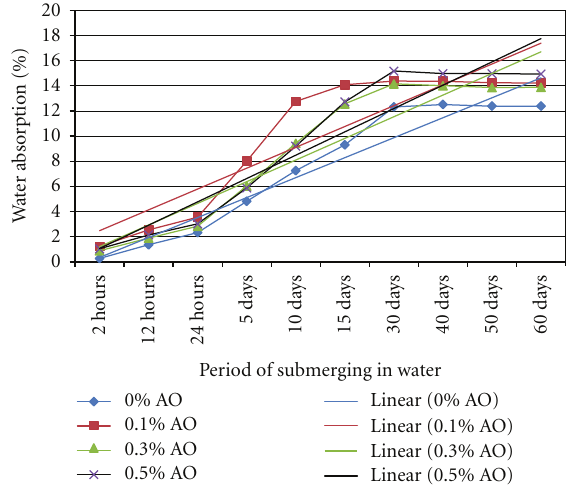
Figure 3: Graph water absorption of corotating twin-screw ex- truder.